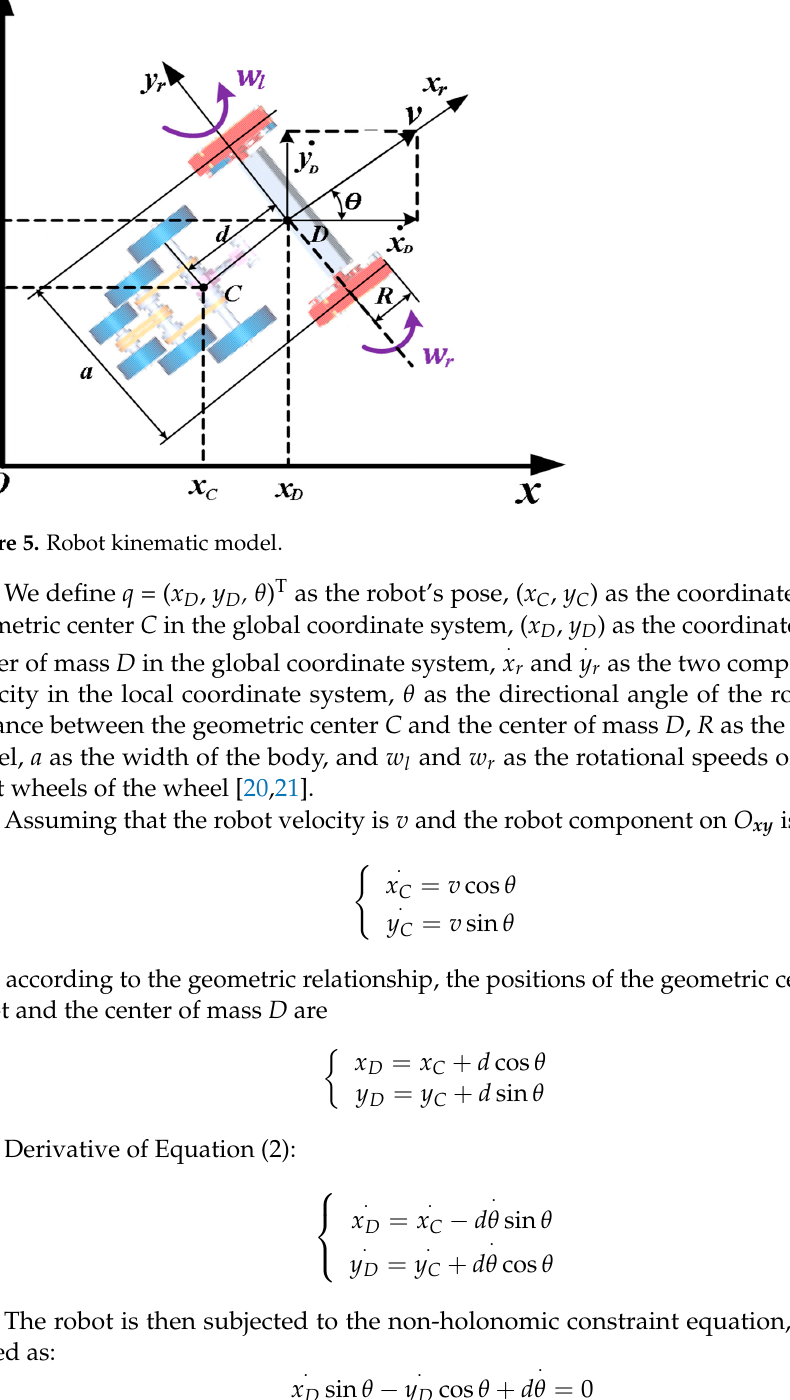
( b ) Figure 4. Adaptive tail. ( a ) Structure of the adaptive tail; ( b ) Sketch of the motion of the adaptive tail mechanism.